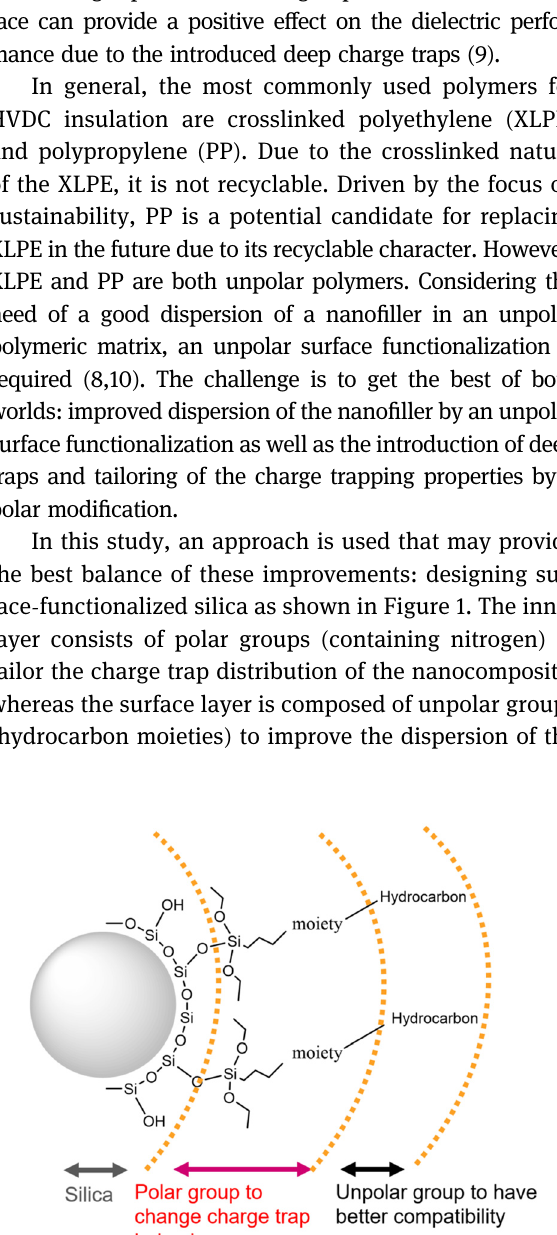
( Figure 4 ) . The procedure of solvent - free modi fi cation